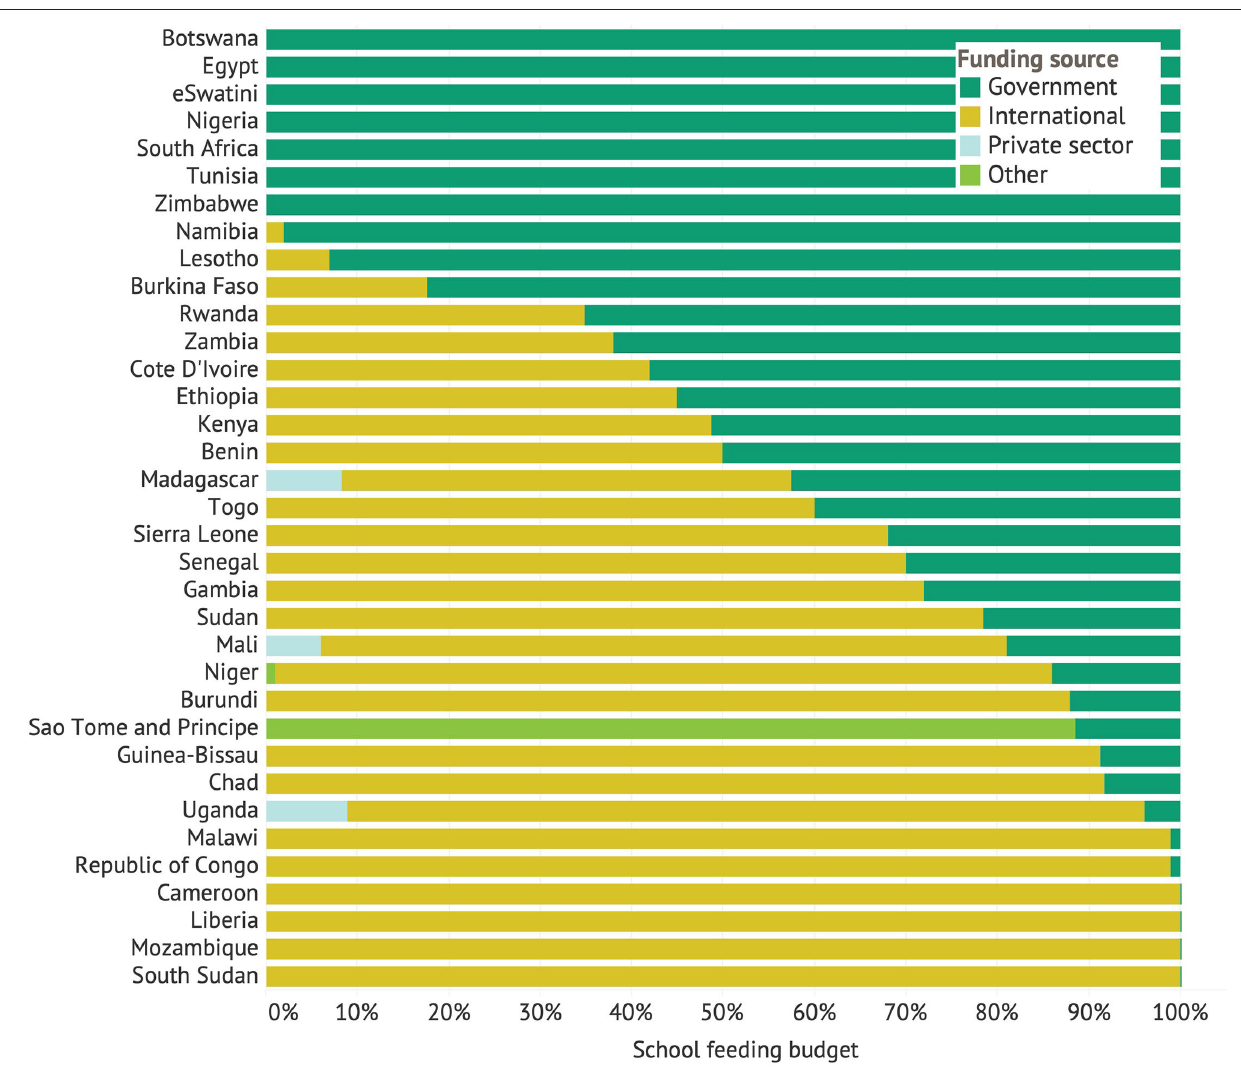
Frontiers in Public Health |